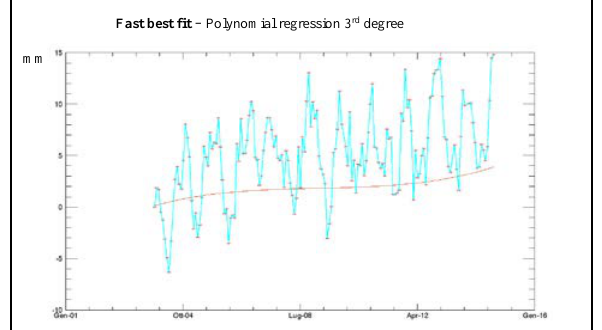
Figure 4. Polynomial interpolation (3 th degree) of the area (red) and vertical displacement temporal series of a point inside the storage field (light blue) 5.2.2 Residual curve The altimetric residual curve was computed on the whole scene. In Figure 5 it is shown the residual curve deriving from the